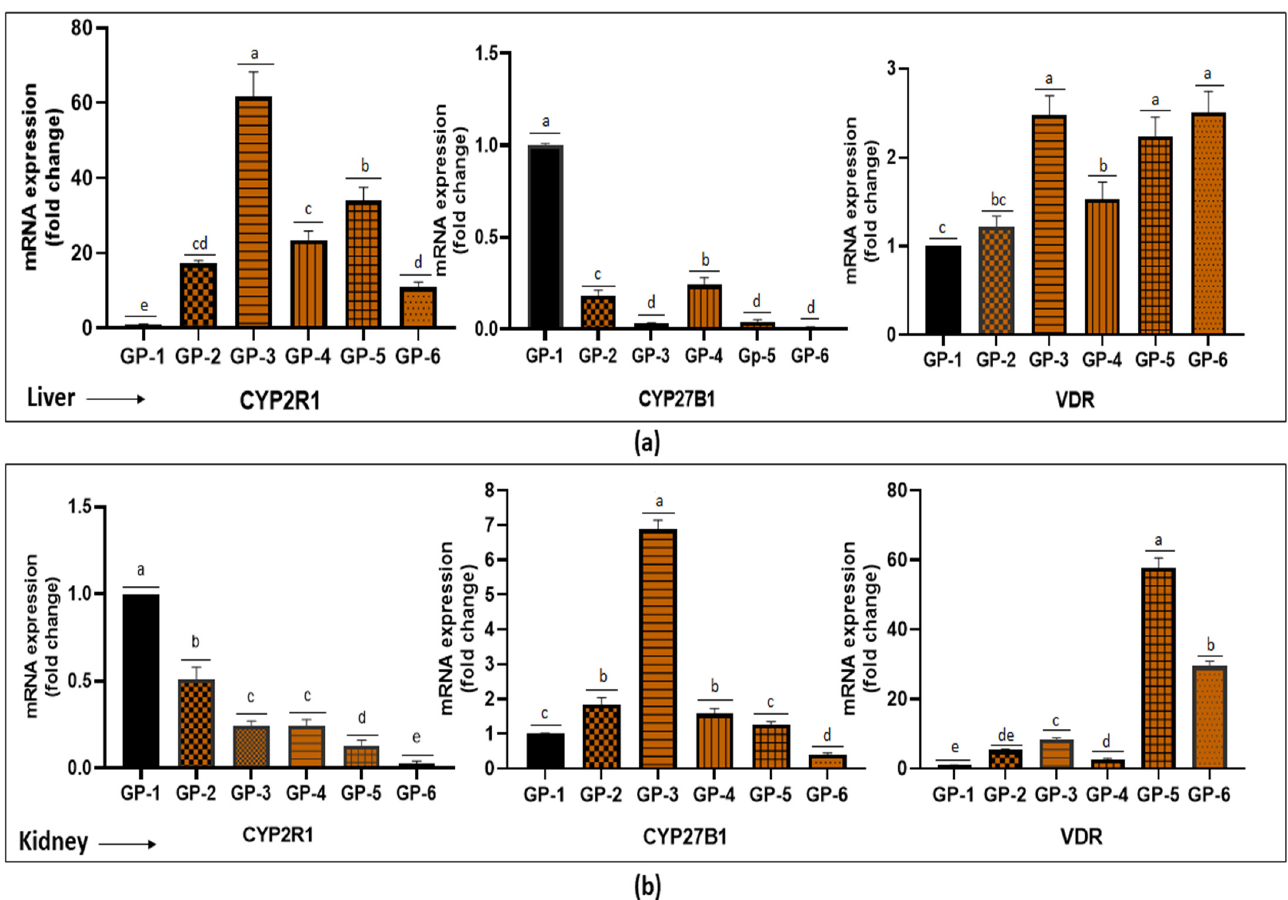
Figure 5. Effect of UV-exposed mushrooms and vitamin D supplementation on the expression of CYP2R1, CYP27B1 and VDR genes in the liver ( a ) and kidney ( b ). Values are presented as mean ± SD for n = 6. The experimental values within any specific group that do not have a common superscript are significantly different ( p < 0.05) based on Tukey’s post hoc test.